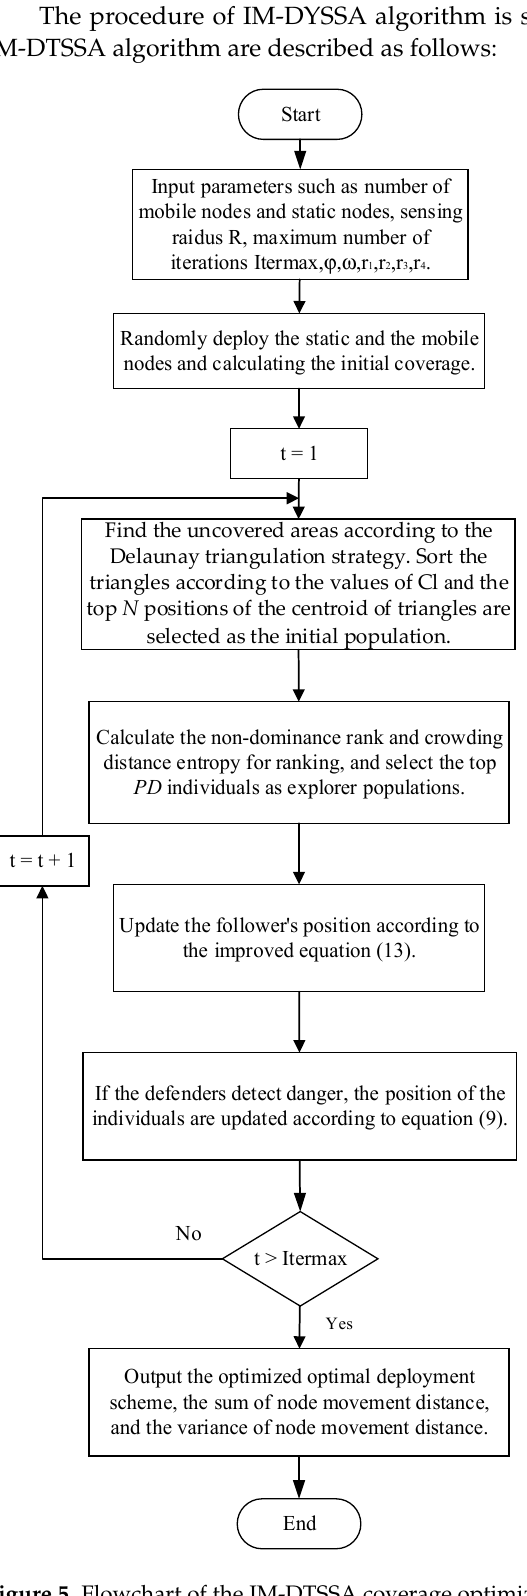
Figure 5. Flowchart of the IM-DTSSA coverage optimization algorithm.